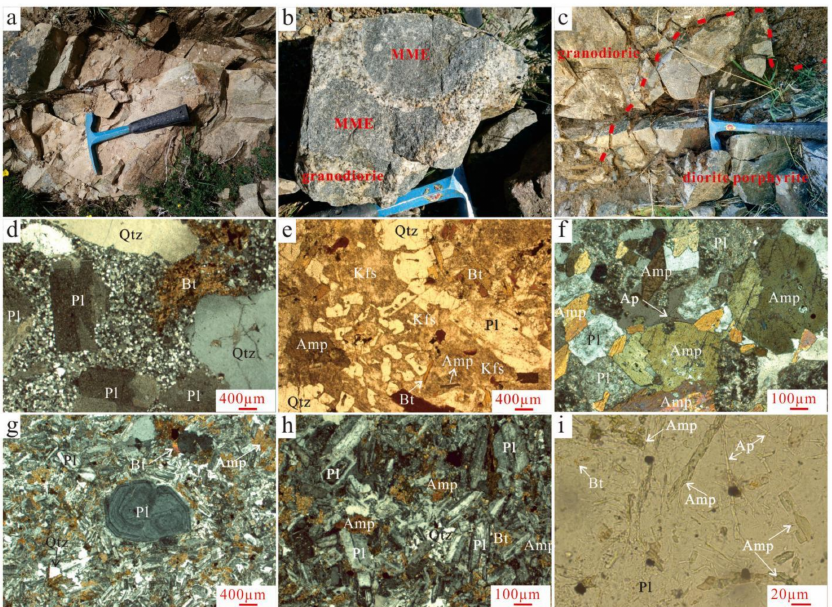
Figure 3. Field photographs and photomicrographs of the intermediate-acid intrusive rocks in the Ela Mountain area. ( a ) Porphyritic granite (field photos). ( b ) Host granodiorite and mafic microgranular enclave (MME) sample (field photos). ( c ) Field contact relationship between granodiorite and porphyritic diorite (field photos). ( d ) Porphyritic granite (cross-polarized light). ( e ) Granodiorite (plane-polarized light). ( f ) MME (cross-polarized light). ( g , h ) Porphyritic diorite (cross-polarized light). ( i ) Porphyritic diorite (plane-polarized light). Mineral abbreviations: Pl, plagioclase; Qtz, quartz; Bt, biotite; Kfs, K-feldspar; Amp, amphibole; Ap,